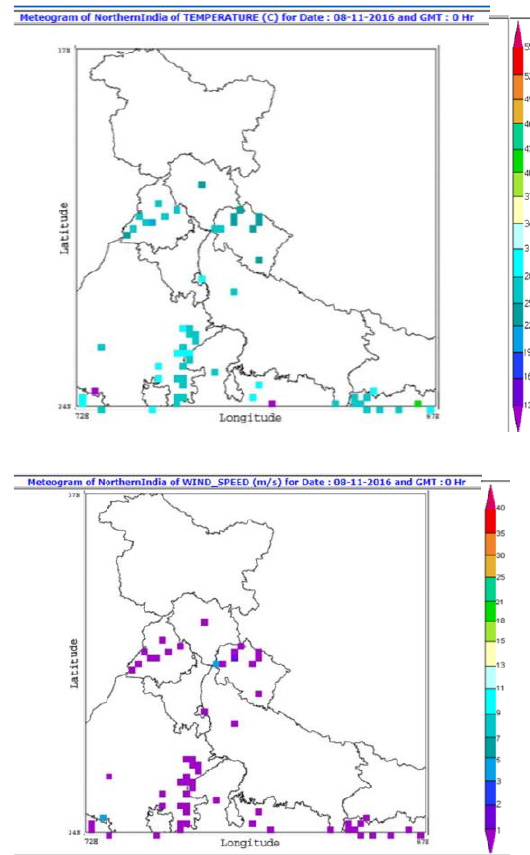
Figure 12: Temperature and Wind Speed, November, 2016